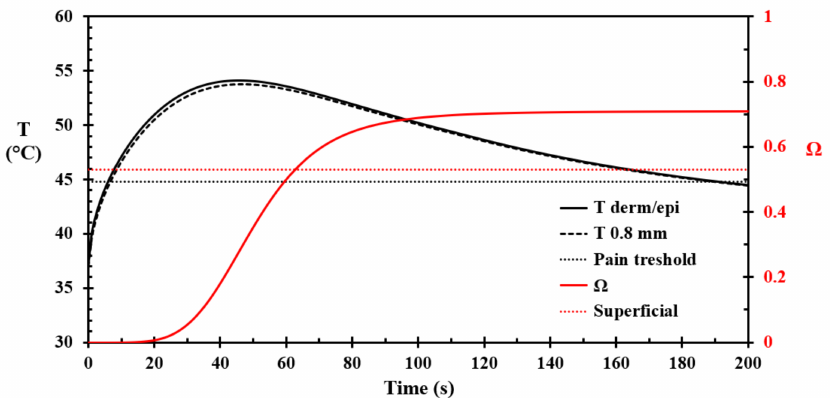
Figure 9. The basal layer and 0.8 mm depth skin temperature, and the corresponding damage integral development, versus time for Case 4, i.e., 4.0 kW/m 2 , as the flare heat flux to the most exposed point at the